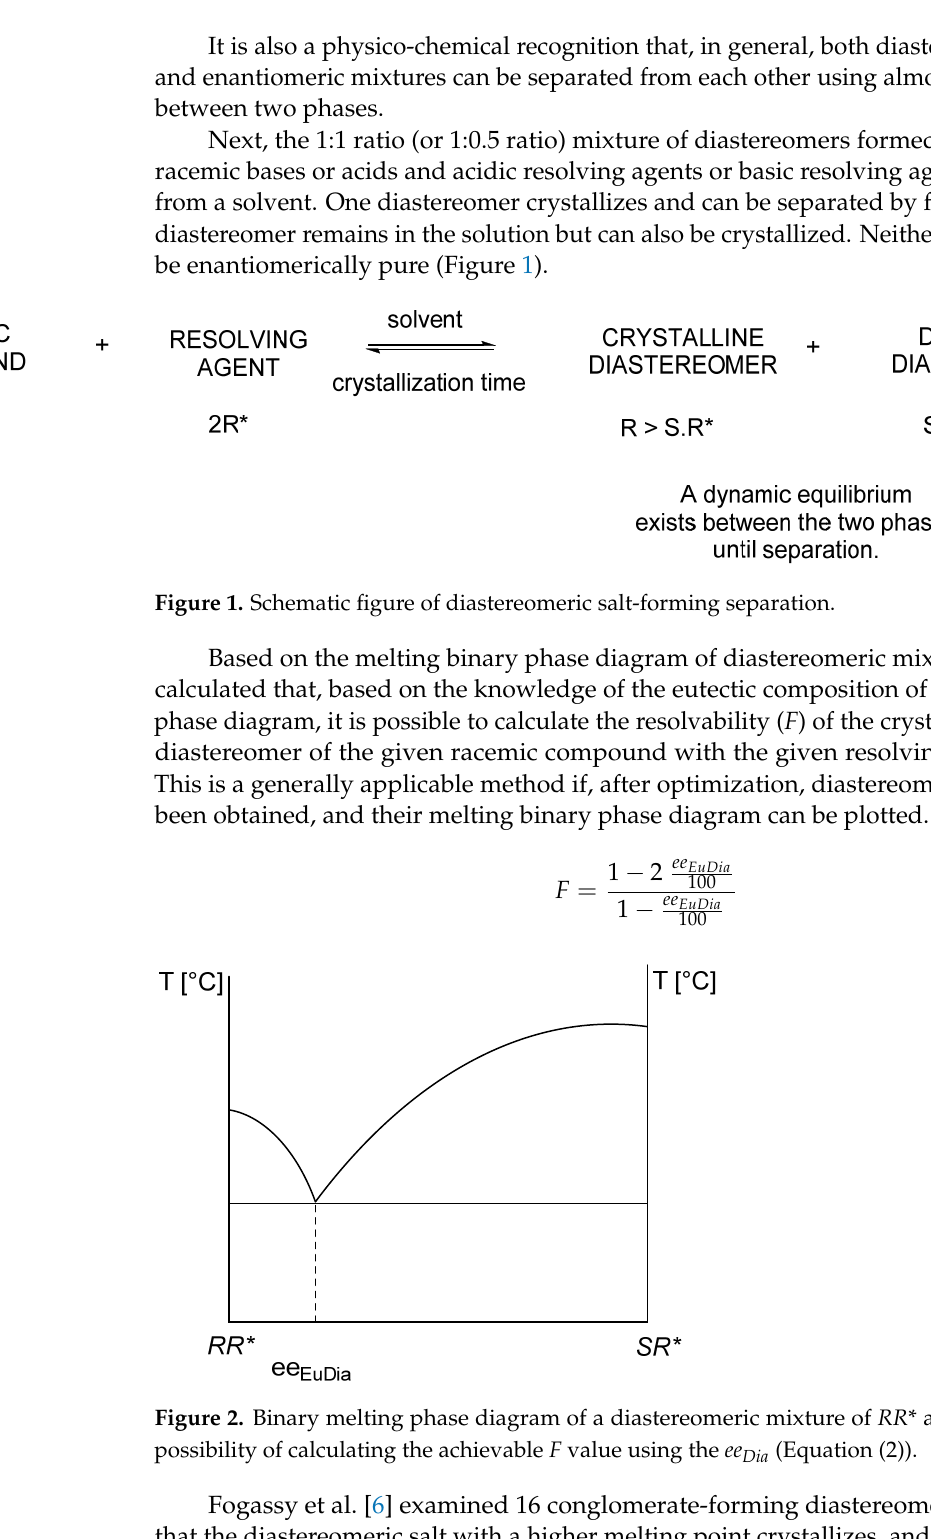
Figure 3. Resolution of a racemic α -amino acid derivative with one of its enantiomeric de- rivatives .